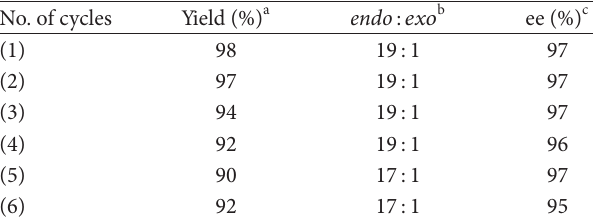
T 4: Recyclability of MacMillan’s imidazolidinone